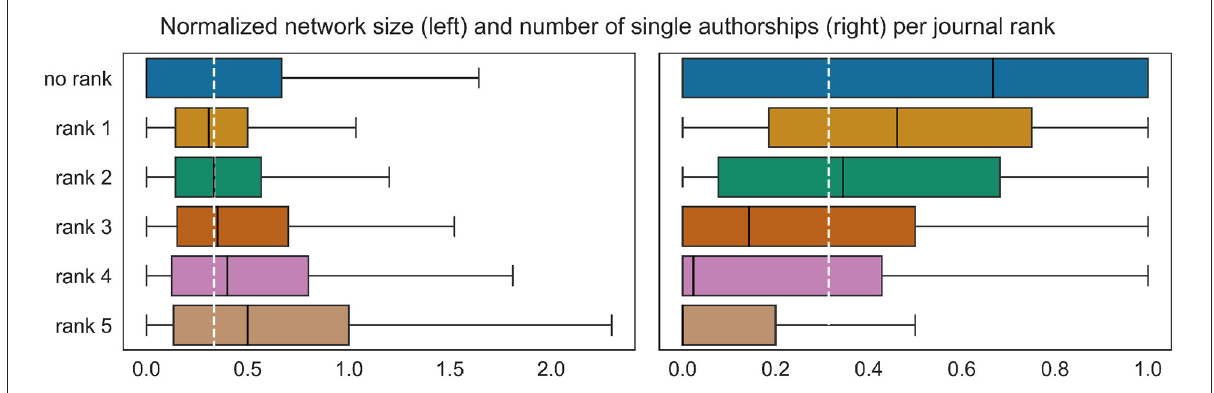
FIGURE3 Differences in the value distributions of the target variables between journal ranks. The target variables were normalized as in Figure 2. The white dashed line marks the normalized mean of the entire data. The overall difference is statistically significant with p -value 0.01, measured with one-way